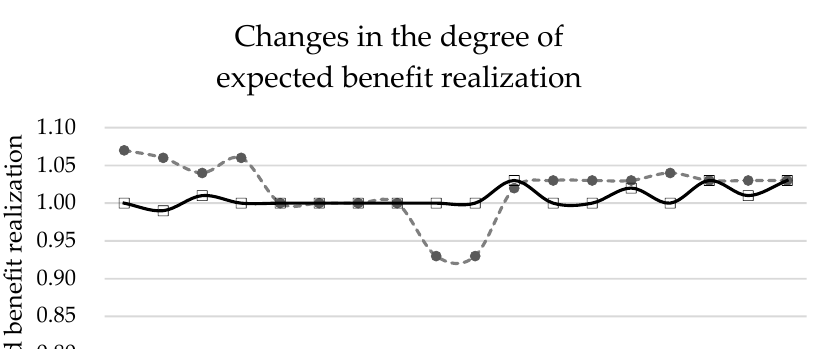
Figure 3. Changes of agent benefits.